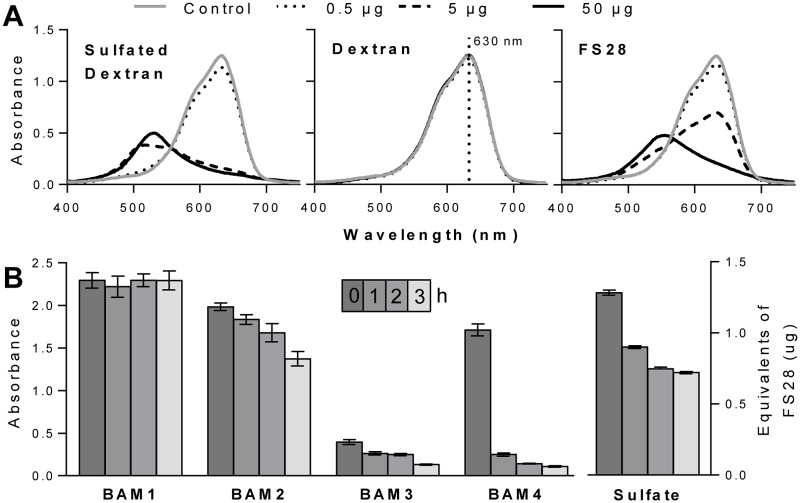
Sulfate assay and de-sulfation.(A) Azure A absorbance spectra changes in the presence of differing levels (0 to 50 μg) of sulfated dextran, dextran and FS28. (B) Effect of de-sulfation on BAM MAb recognition of FS28. Samples of FS28 were collected over 4 time points (0, 1, 2 and 3 h) during a de-sulfation treatment with chlorotrimethylsilane and assayed using ELISA. Absorbance values are means of 4 replicates and error bars indicate SD. Sulfate levels as equivalents to native FS28 (w/w).